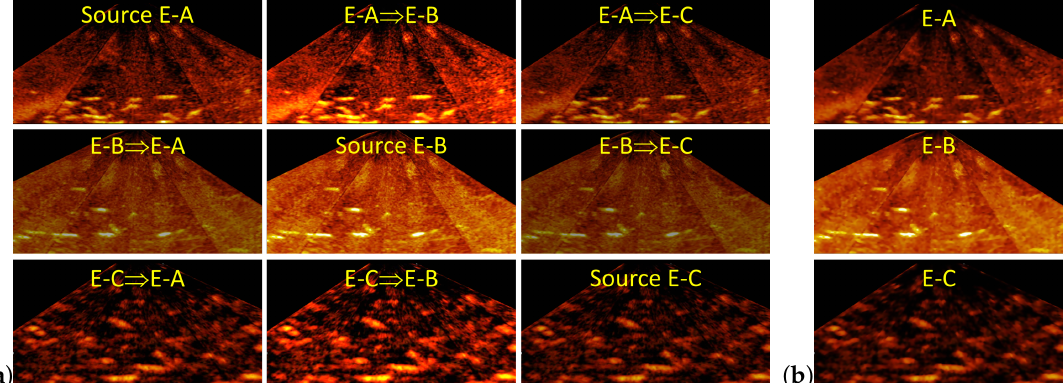
Figure 8. Examples of sonar images processed with contrast stretching and bilateral filtering, where ( a ) shows the source sonar image and the image transformed from the source image into the image for the target environment by contrast stretching; ( b ) shows the source image processed with a bilateral